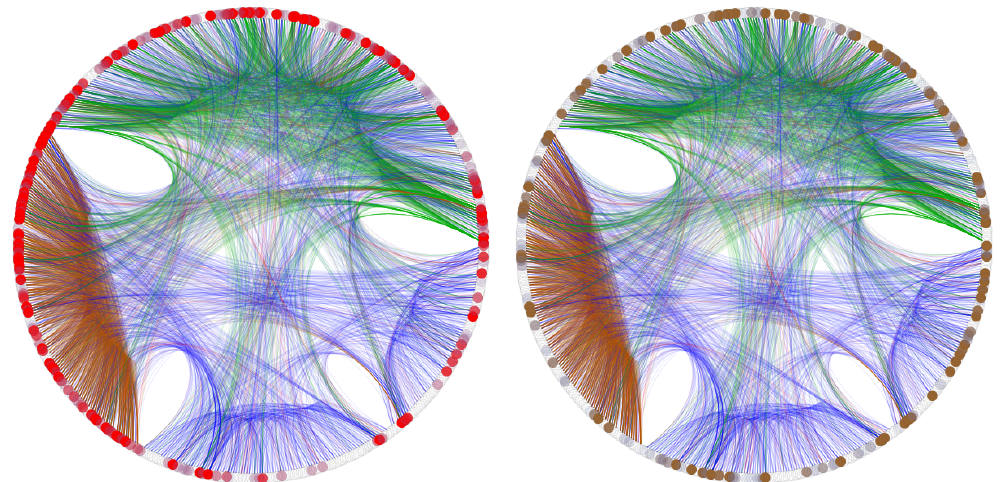
Figure 4. Visualisations of the multiplex lexical network of normative learners at age 30 months. Nodes are reported in a circular embedding and links are bundled according to a hierarchical edge bundling algorithm as implemented in Mathematica 11.3. Blue links indicate free associations, green is for co-occurrences, brown for semantic feature sharing and red links denote phonological similarities. Left : nodes in the 90th percentile of the multiplex closeness distribution are highlighted in red. Right : nodes in the 90th percentile of the free association degree distribution are highlighted in